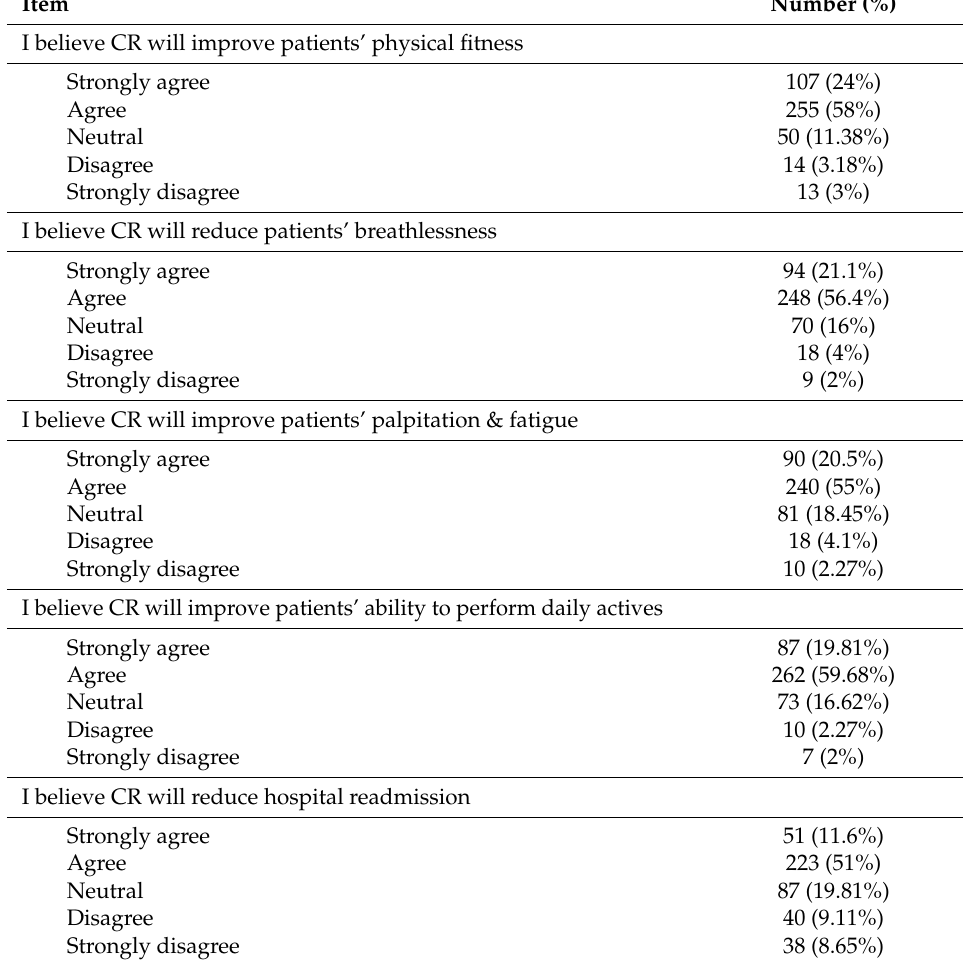
Table 2. Perception on referring patients with heart failure to cardiopulmonary rehabilitation ( n =